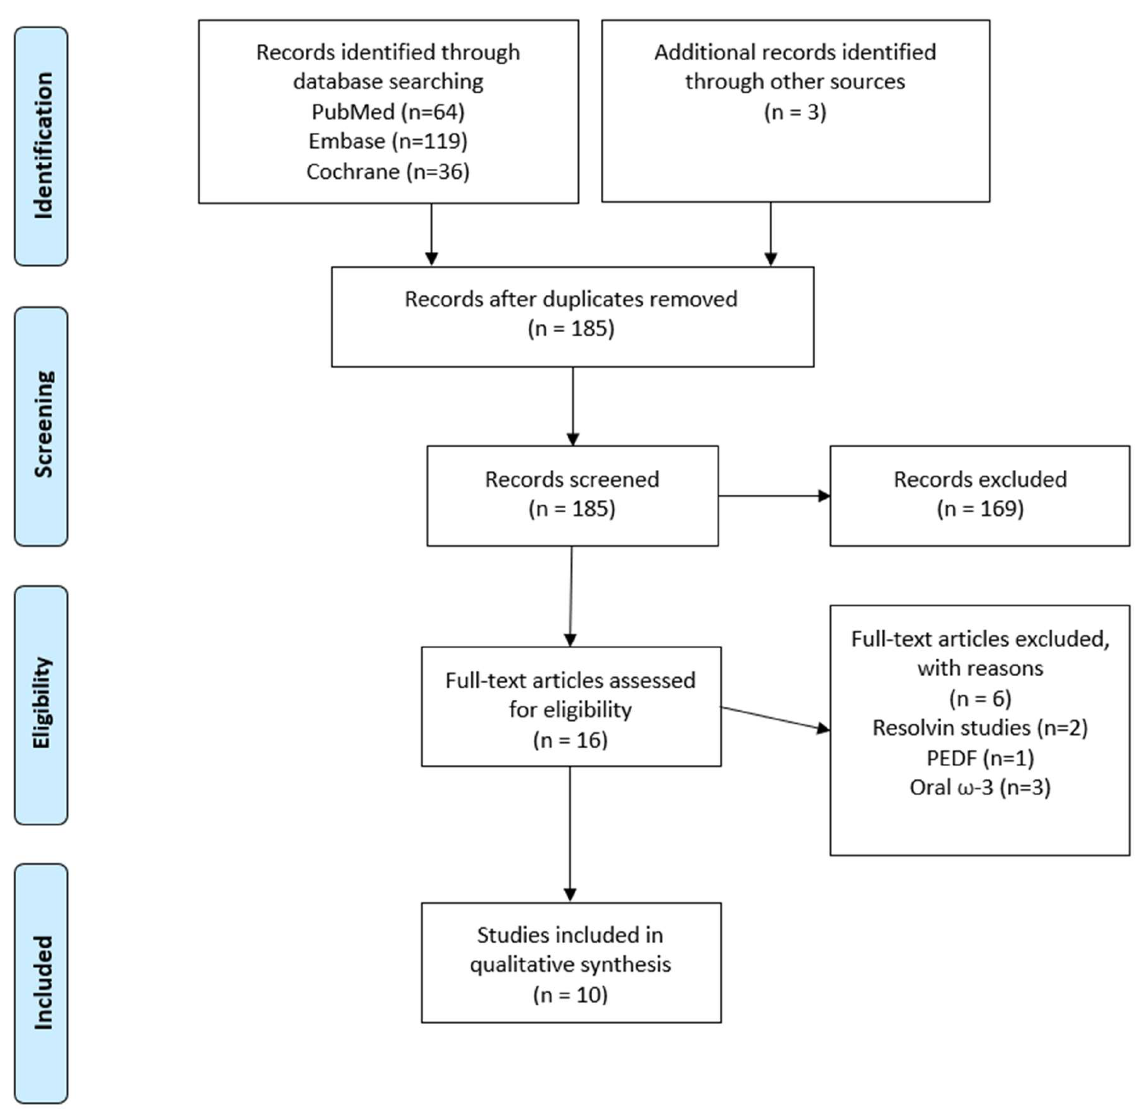
Figure 1. PRISMA flow diagram (PEDF = pigment epithelial-derived factor). Two studies [40,43] contributed 273 patients with idiopathic DED, comprising a prospective observational (PO) single-arm open-label study on DHA-containing eye- drops by Jacobi [40], and a double-masked RCT by Downie [43] comparing a flaxseed oil-containing eyedrop with Refresh Optive Advanced. While Jacobi only included patients with DED due to MGD, Downie included all DED patients. Both studies included patients of older age groups (mean age > 50) who had moderate [43] to severe [40] DED, had a female preponderance of around 70% in both studies, and excluded patients using contact lenses, desiccating eyedrops, and with a history of corneal trauma; of note, only Downie’s study allowed patients to continue any cyclosporine eyedrops during their study. Another study on CLD-DED patients compared topical or oral EPA/DHA to olive oil control [44]. All patients were soft lens wearers for >6 months with symptomatic CLD and minimal to mild corneal